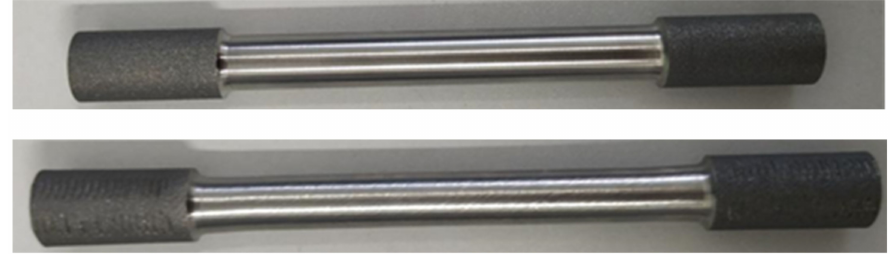
Figure 4. Comparison of specimens before and after